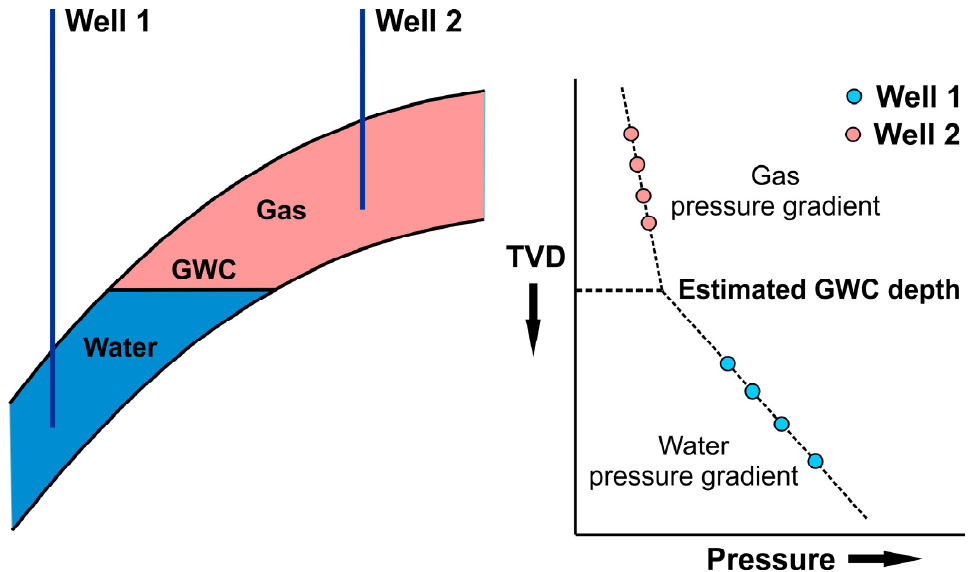
8 Figure 8. Estimation of fluid contact depths by means of formation pressure measurements, even if the actual contact is not intercepted by exploration